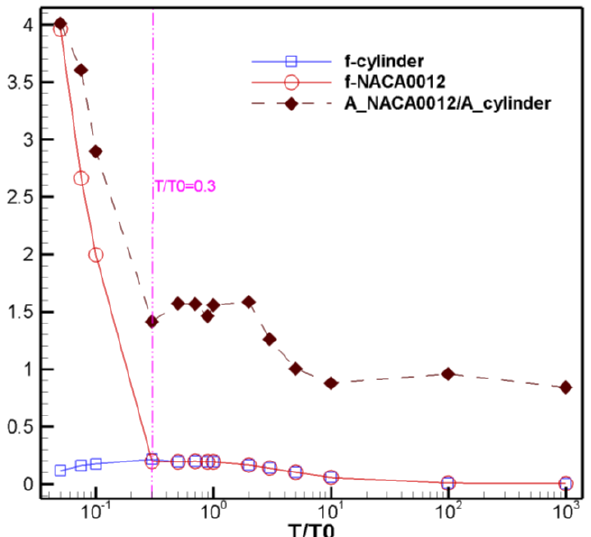
Figure 7. Lift coefficient frequency and amplitude ratio of cylinder and airfoil ( x / D = 2.5).